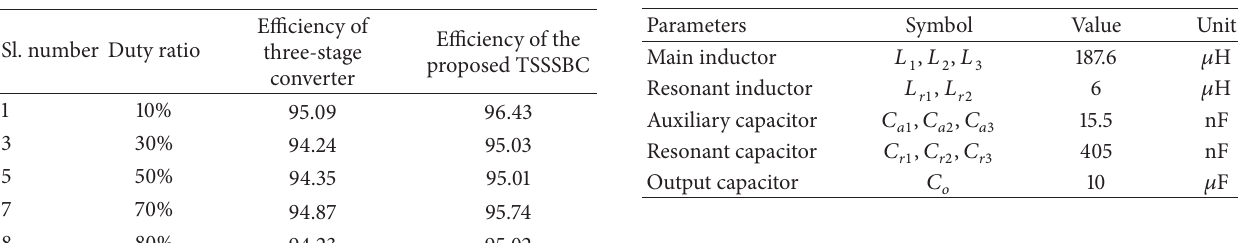
Table 7: Specifications of the